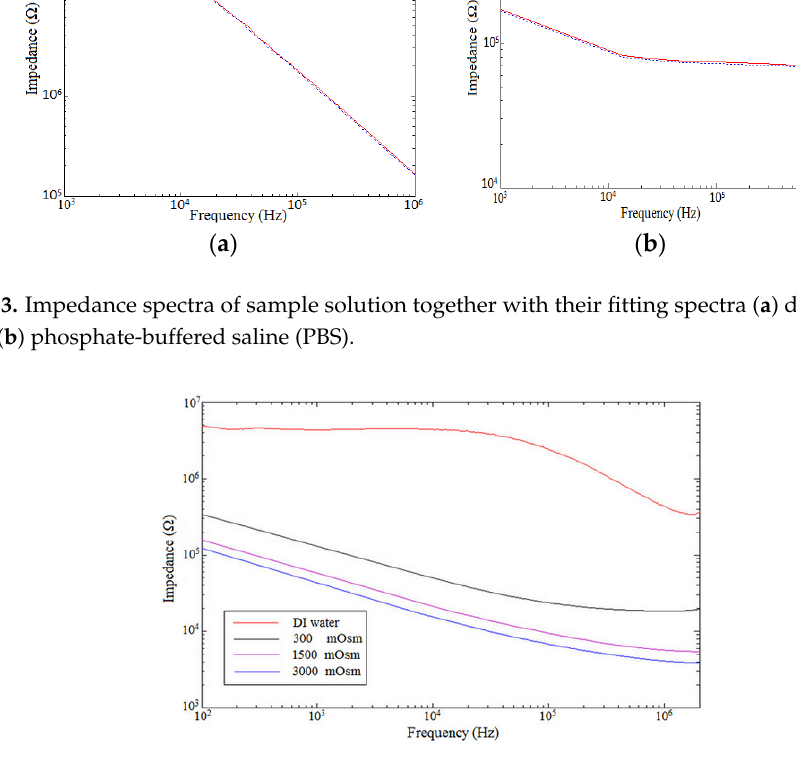
Figure 5. Image of the sensing area of the device.